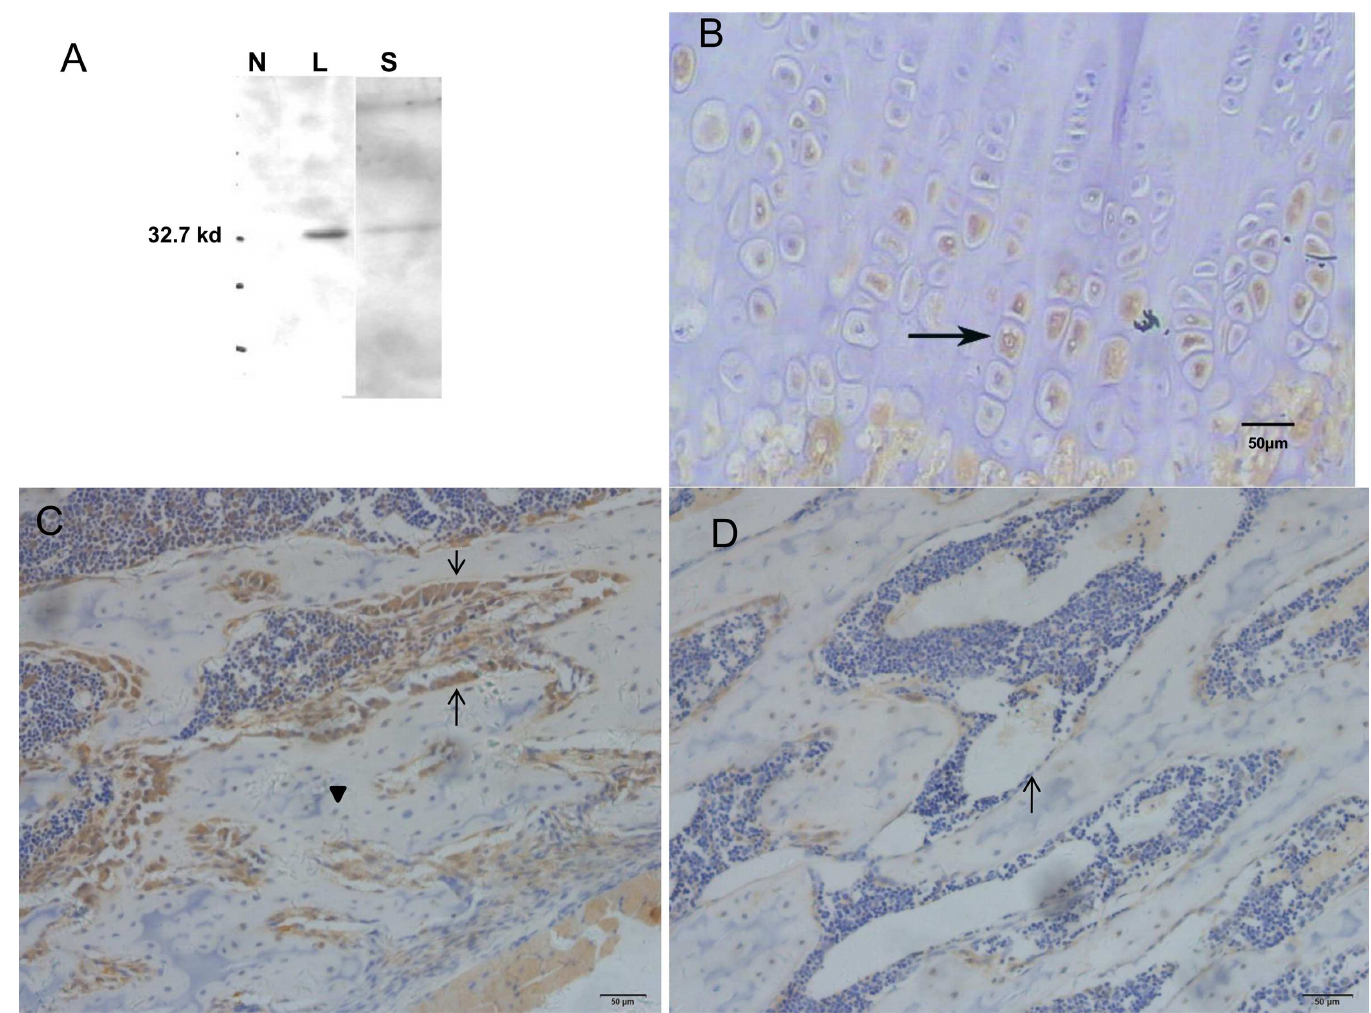
Fig 2. Immunohistochemistry for METRNL protein in rat bone. (A) In western blotting analyses, METRNL expressionis observedin lysates (L) and supernatants (S) of stable CHO cells overexpressing His-taggedMETRNL, indicatingthat METRNL indeedis a secreted protein and the polyclonalantibody was specific to METRNL (N for lysates of CHO cells). (B) METRNL is detected in hypertrophicchondrocytes ( ! ) in the tibial growth plate of three-week-old rats. (C) In the primary spongiosa, METRNL is detected in osteoblasts ( ! ) lining the trabecular bone surfaces, but osteocytes ( ▼ ) are absent.(D) In